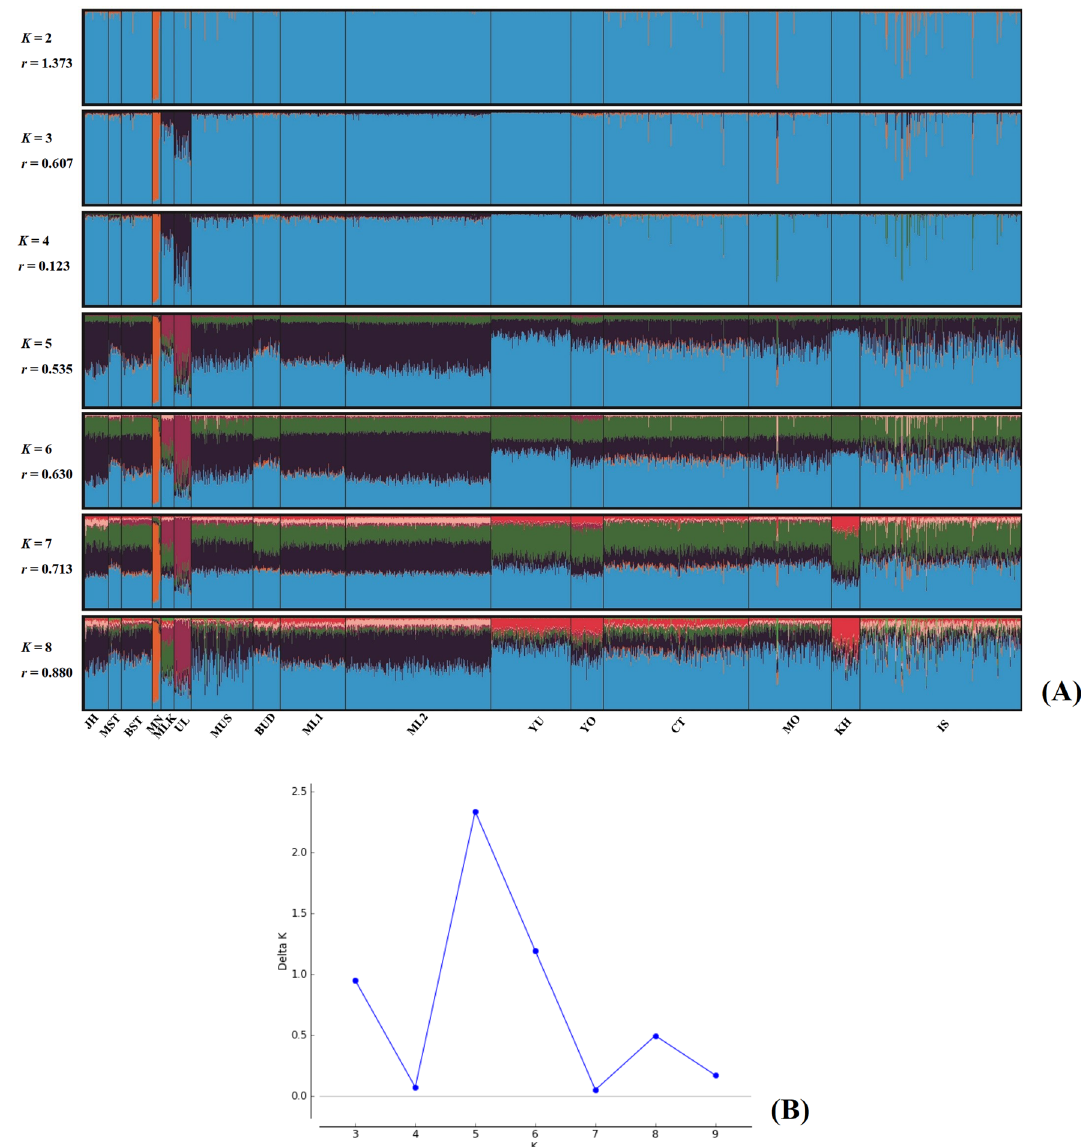
Figure 3. STRU CTU RE result at K = 2–8 ( A ). Each individual is represented by a single column that is divided into segments whose size and color correspond to the relative proportion of a particular cluster. Populations are separated by black lines and population codes are listed in Table 1. Number of populations with the highest posterior probability expressed as the Delta K ( B